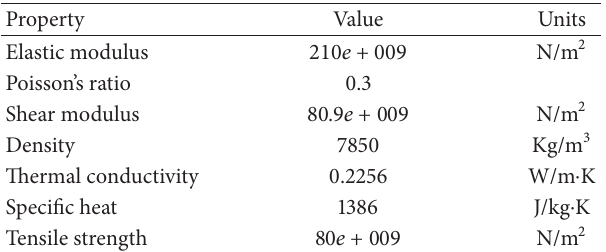
Table 3: Material specifications for Steel